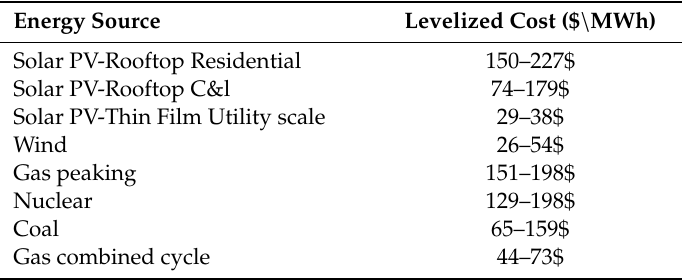
Table 1. Levelized cost of Energy Comparison